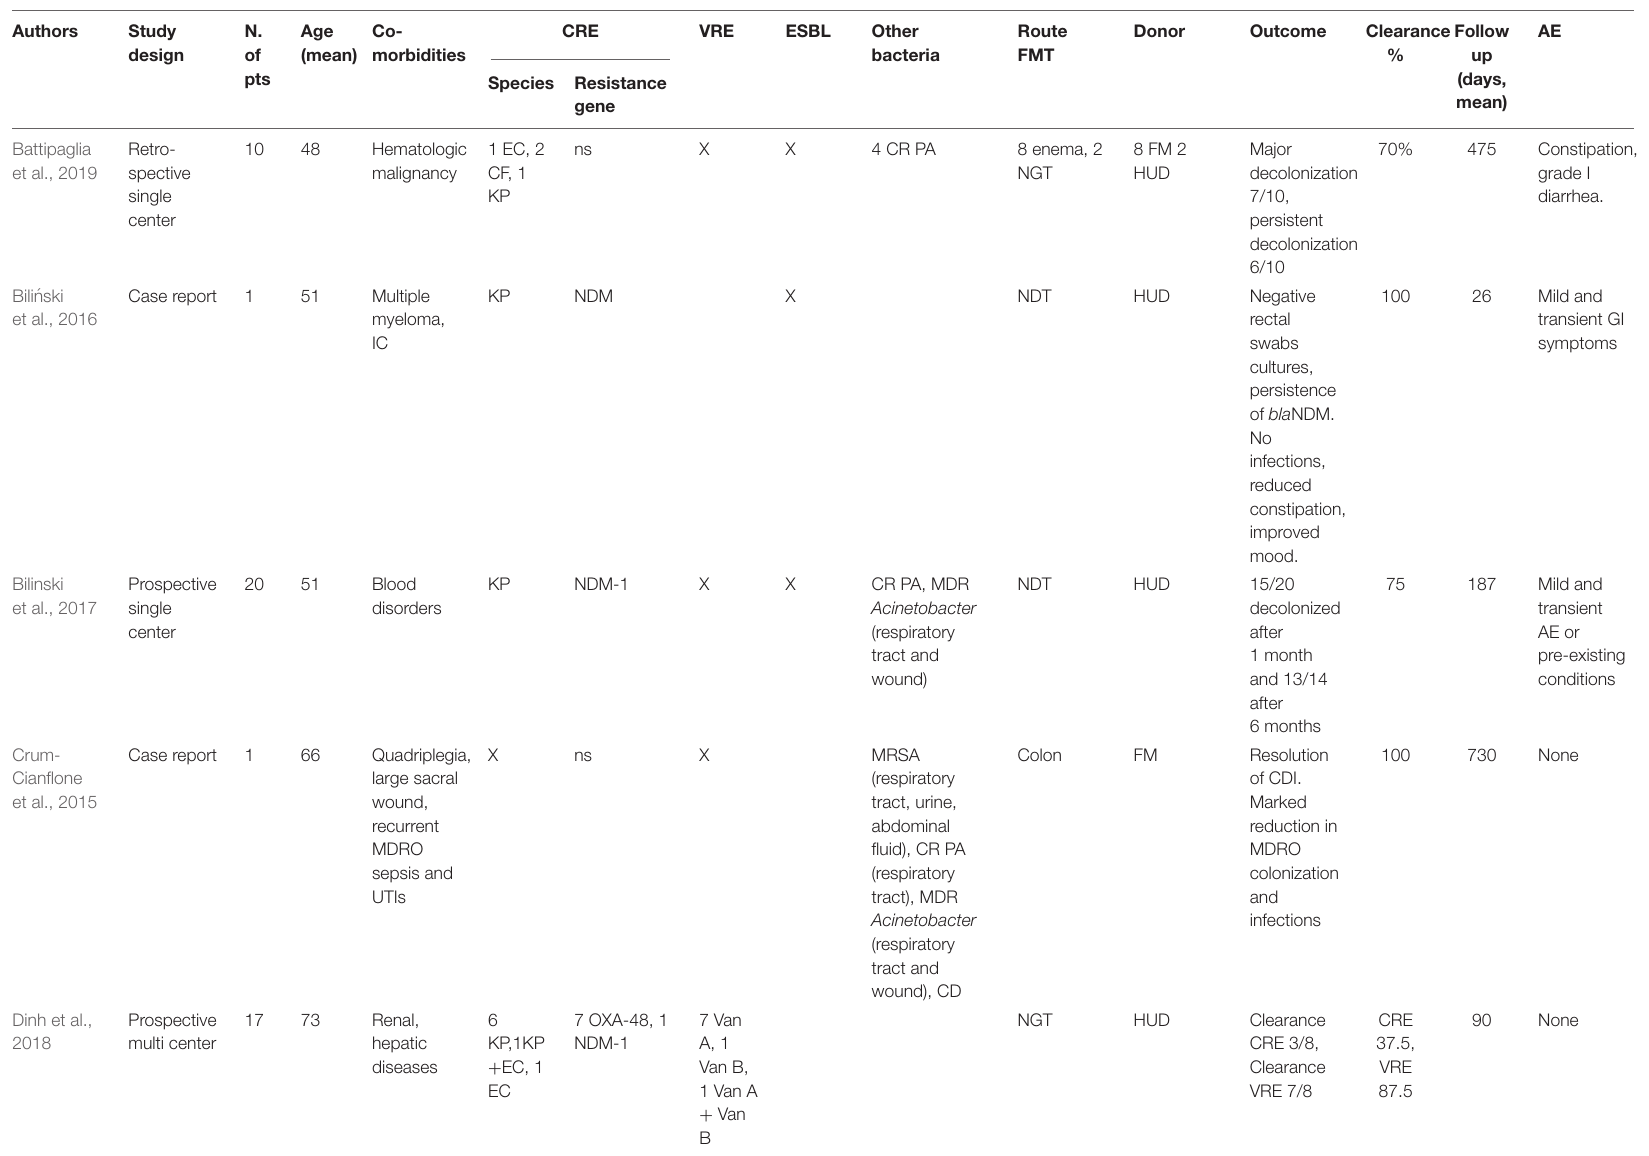
TABLE 1 | List of case reports and studies describing FMT for MDR intestinal